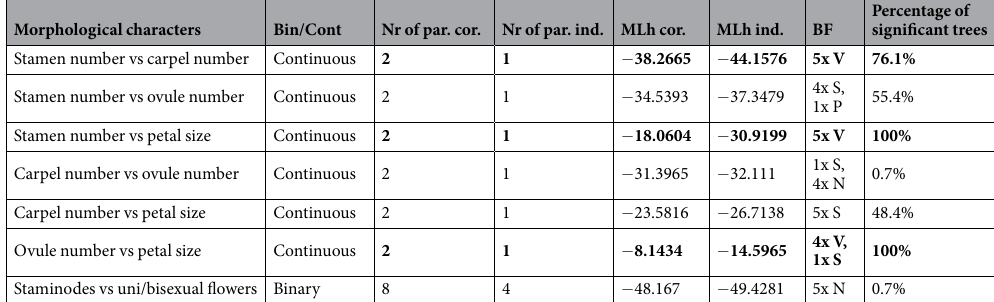
Table 1. Results of model tests of correlation between morphological characters. BF = results of 5 Bayes Factor tests, percentage of significant trees = percentage of trees with significant correlation using likelihood ratio test for continuous characters (p < 0.05) and using relative likelihood of AIC for the binary characters. Bin = Binary characters, cont = continuous characters. Nr of par. cor. = Number of rate parameters of model with correlation, nr of par. ind. = number of rate parameters of model without correlation. MLh cor. = Best marginal likelihood of the stepping stone sampler of the five MCMC runs of the model with correlation, MLh ind. = Best marginal likelihood of the stepping stone sampler of the five MCMC runs of the model without correlation. V = very strong indication of correlation, S = strong indication of correlation, P = positive indication of correlation, N = no or weak indication of correlation. In bold are the results which show a correlation for both types of test.